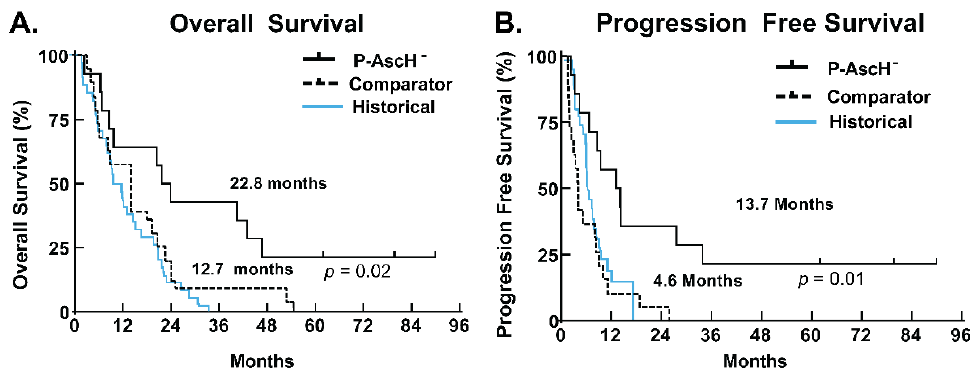
Figure 1. Survival analysis from phase I trial (NCT01852890). ( A ) Kaplan–Meier curve estimating median overall survival in subjects treated with P-AscH – plus gemcitabine and radiation therapy as of 25 January 2022 ( n = 14) was 22.8 months vs. 12.7 months in institutional controls treated with gemcitabine and radiation therapy ( n = 19, Log-Rank test p = 0.02); ( B ) Kaplan–Meier curve demonstrating median progression-free survival in subjects treated with P-AscH – plus gemcitabine and radiation therapy as of 25 January 2022 ( n = 14) was 13.7 months vs. 4.6 months in institutional controls treated with gemcitabine and radiation therapy ( n = 19, Log-Rank test p = 0.01). These data are updated from data previously published by Du et al. [60].